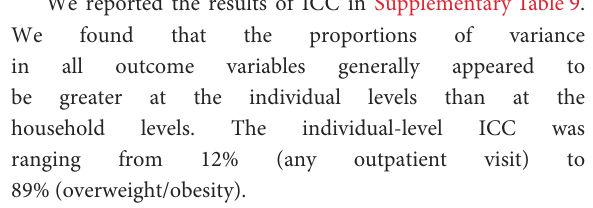
of CVD compared with high physical activity. The